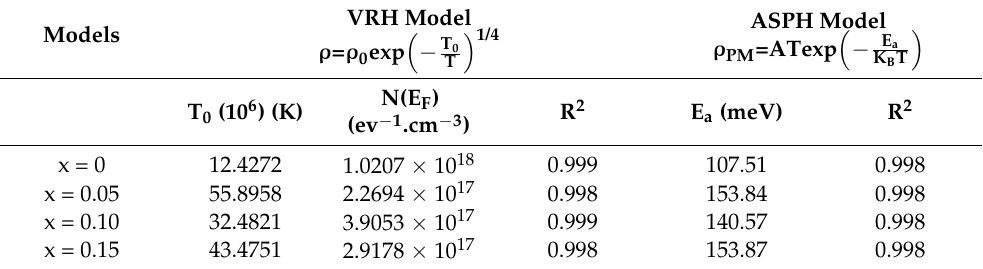
Table 9. Values of activation energy Ea, correlation factors R and Mott temperature (T 0 ) for